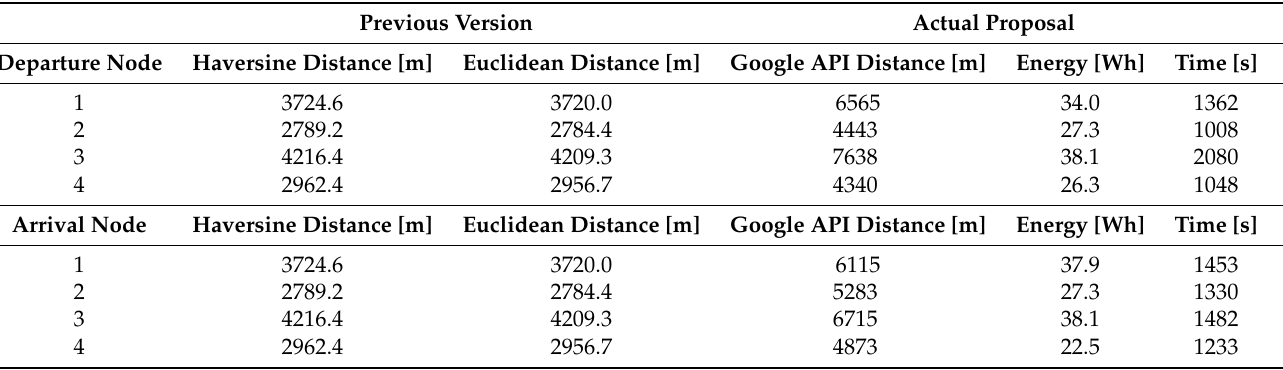
Table 2. Numeric results of customer route deliveries for e-bikes.